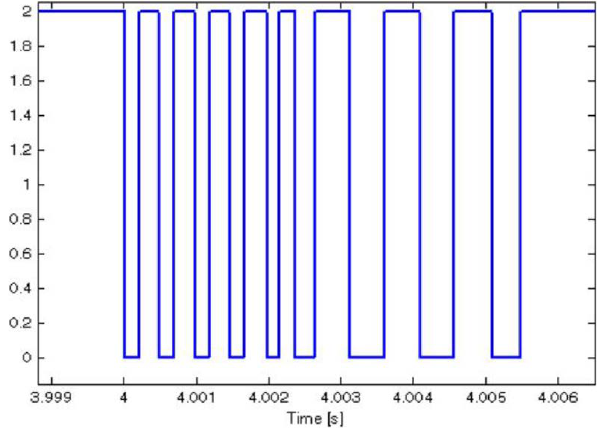
Figure 27. Scaled up picture from Fig.